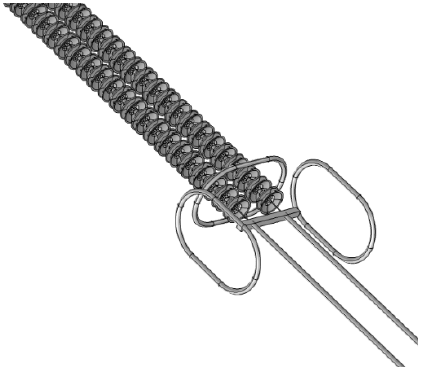
Figure 6. The 3-D simulation calculation model of the electrostatic field in the grading ring and shielding ring areas of tension insulator strings. shielding ring areas of tension insulator strings.